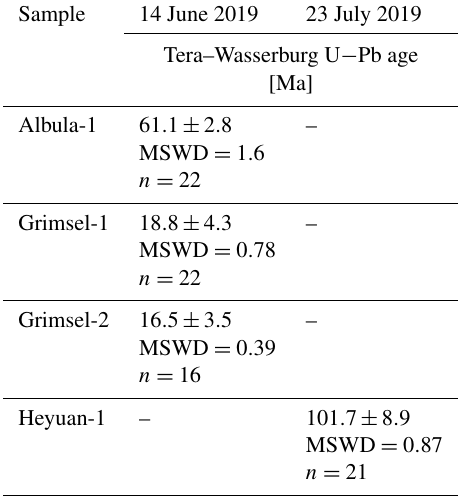
Table C1. U − Pb ages of epidote samples with CAP b (14 June 2019) and CAP (23 July 2019) allanites as primary reference materials. Measurements are with a 50µm spot size. Age uncertainties are 95%